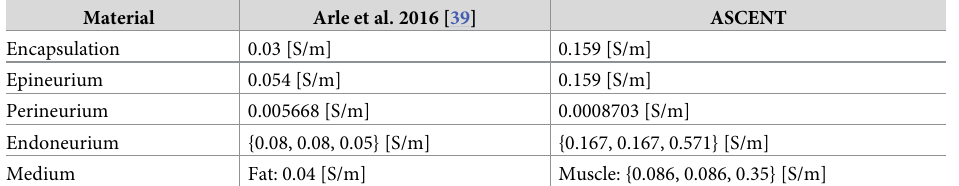
Table 1. Material conductivities used in Arle et al. 2016 [39] and ASCENT.